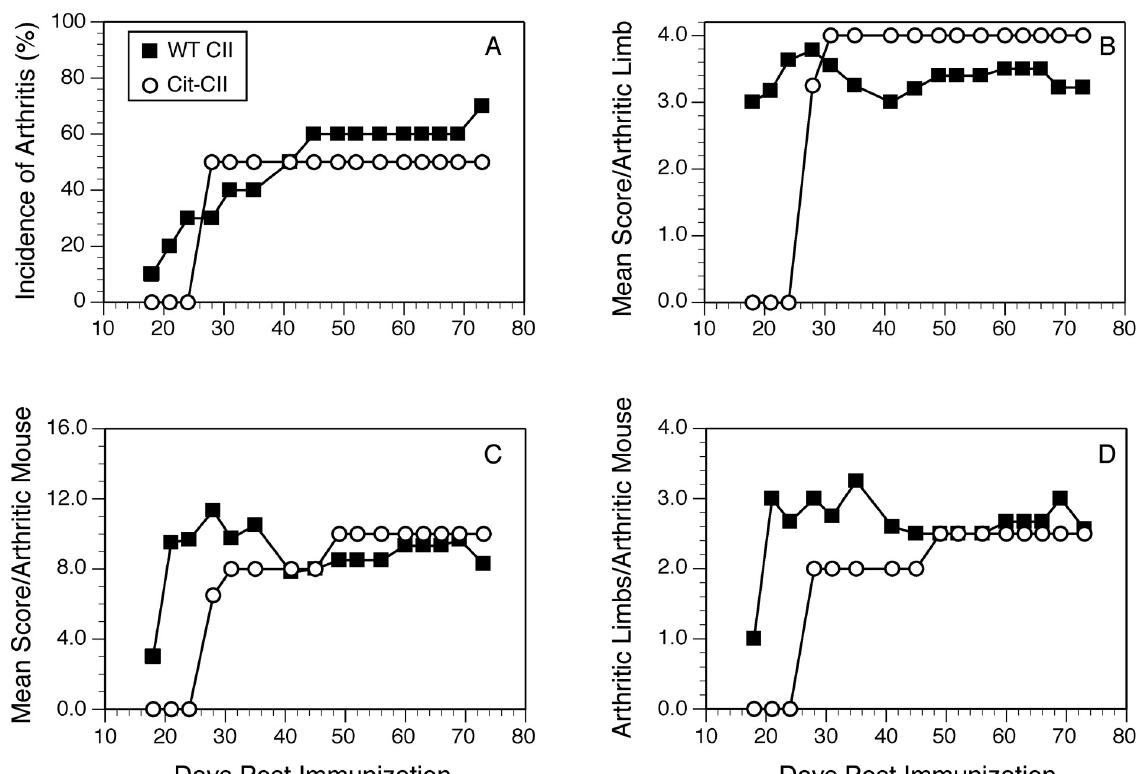
Fig 8. Induction of autoimmune arthritis in HLA-DR1 mice with WT CII and Cit-CII. B6.DR1 mice were immunized with native CII or Cit-CII and the incidence (panel A) and severity (panels B, C, and D) of arthritis were monitored. Disease severity was evaluated on the basis of arthritic animals only, and was assessed using a scale of 0 to 4 as described in Materials and Methods. No significant differences were observed in the incidence or severity of disease between the two groups. Data are representative of two independent experiments.